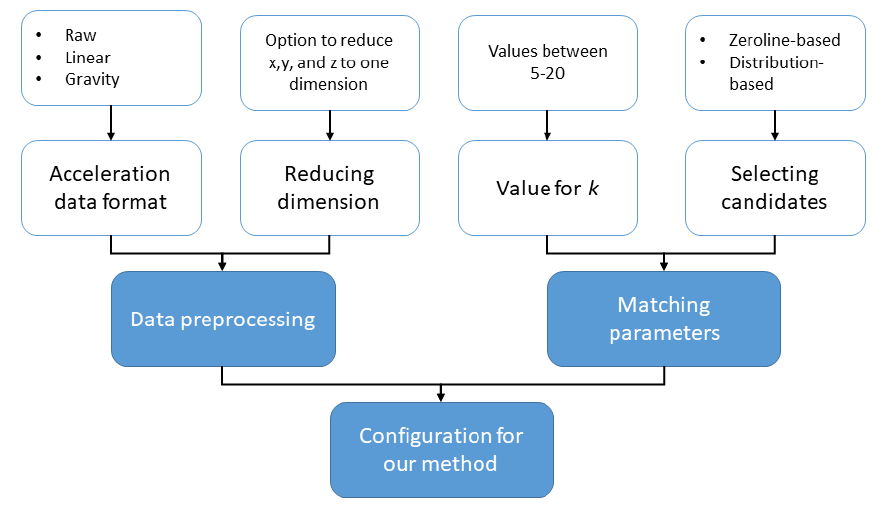
Figure 5. ADL experiment settings. Each parameter is set for a specific configuration of the matching